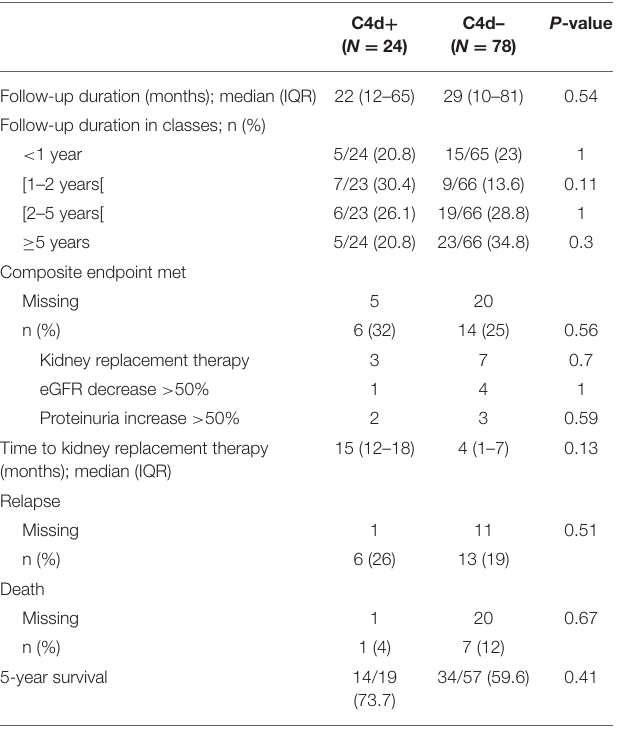
TABLE 3 | Follow-up in a sub-group of patients with 2-year available eGFR data according to the presence or absence of C4d glomerular